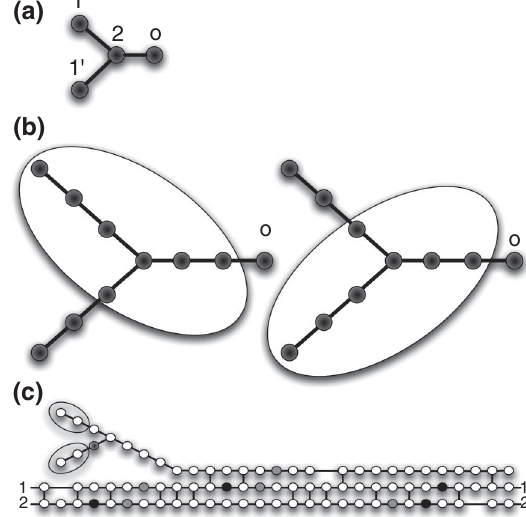
FIG. 10. Gadgets and router. Here, we show the stages in understanding a router. In (a) we show the basic gadget that , can be used to conditionally prepare a (cid:5) 1 eigenstate of X o depending on where the field is applied. (b) is the same con- struction, but now demonstrating the flexibility of the construc- tion to the applied field. The applied field need only cover the desired leg in order to get the correct conditional behavior. (c) is a nonoptimized router construction. If we apply the field every- where but one of the two circled regions, this will route the quantum information incoming at points 1 and 2 and output it at points 1 0 and 2 0 , applying either the identity gate ð 1 ; 2 Þ ! ð 1 0 ; 2 0 Þ or the swap gate ð 1 ; 2 Þ ! ð 2 0 ; 1 0 Þ , depending on which circled region contains a nonzero field. Here, the black nodes are twisted , the grey nodes by (cid:1) (cid:3) , and the gradient-shaded node by (cid:3) by (cid:3) 4 4